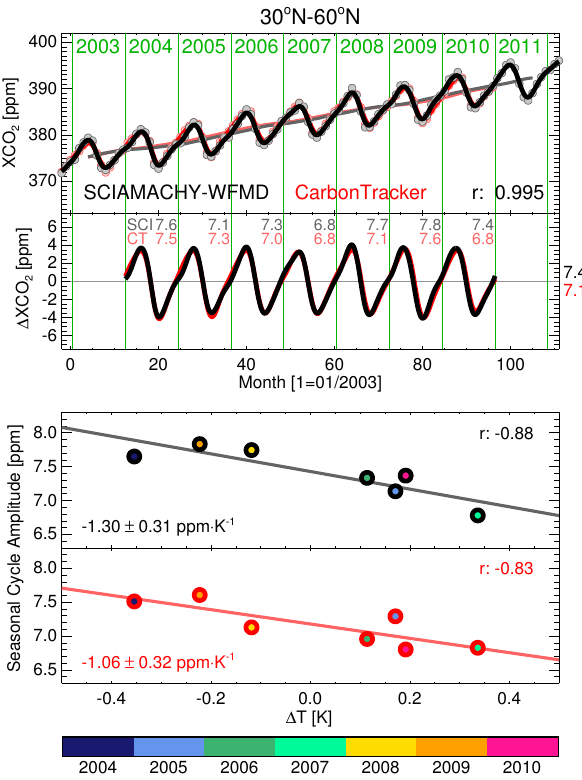
Fig. 6. As Fig. 5 but for the BESD algorithm. The CarbonTracker amplitudes and the corresponding gradient are different from Fig. 5 due to application of different algorithm-specific averaging kernels (see main text for